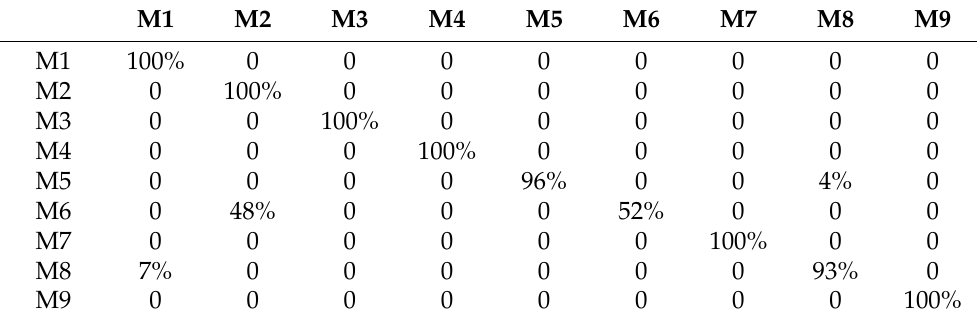
Table 1. Confusion matrix for